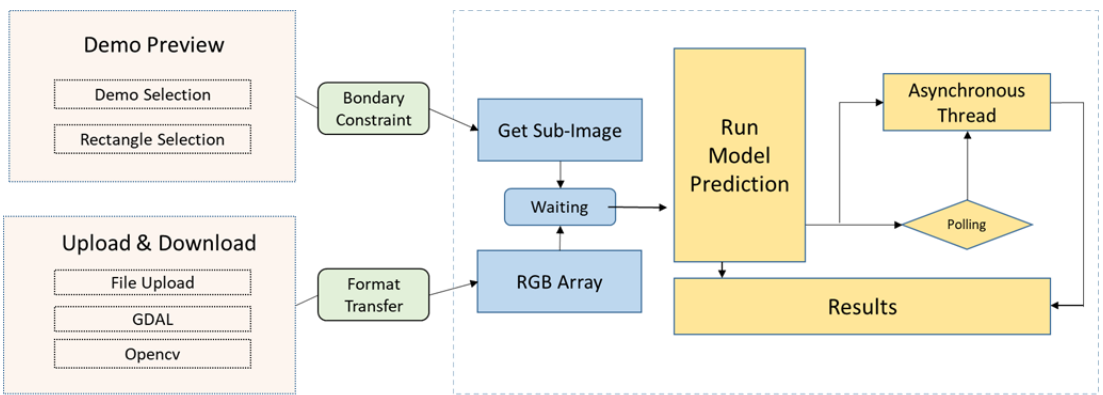
Figure 13. The detailed workflow of the logit layer we design. The structure helps users switch to a preferred mode and handle abnormal cases, hostile attacks, and concurrent assess by a task queue design which makes sure only 5 sub-threads run at the same